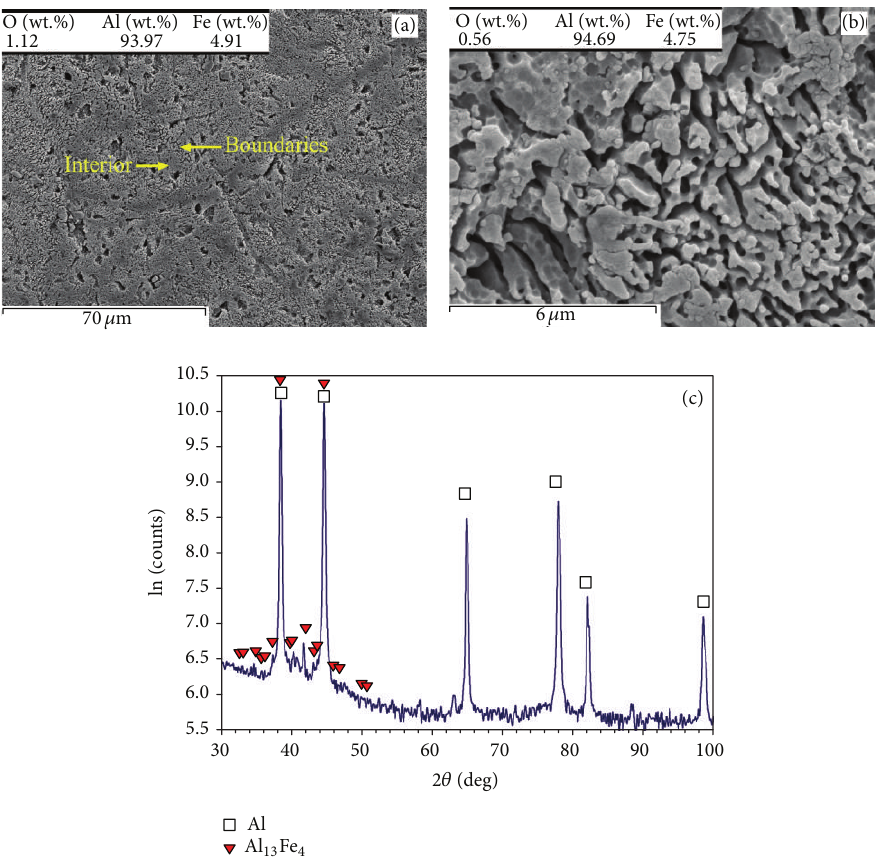
Figure 6: (a) Microstructure, (b) the interior seen in the previous image, and (c) XRD pattern of the part fabricated when 𝑃 = 61 W, V = 0.14 m/s, and 𝑡 = 75 𝜇